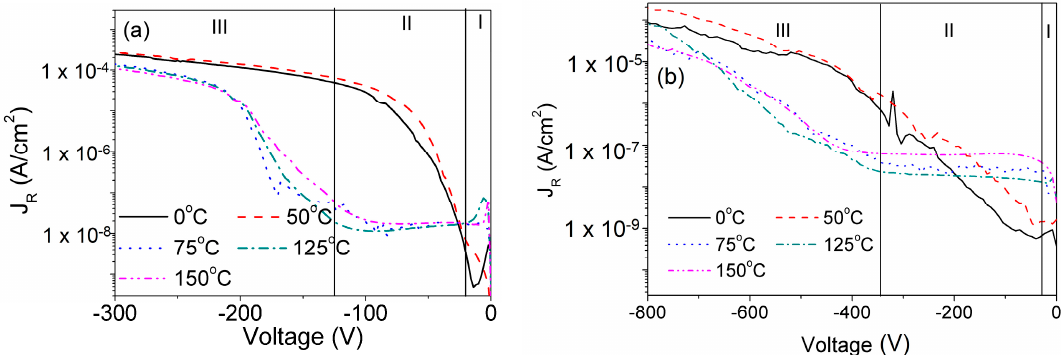
Figure 12. I-V-T characteristics of vertical GaN SBDs with ( a ) 15 µ m DL, ( b ) 30 µ m DL. Adapted from